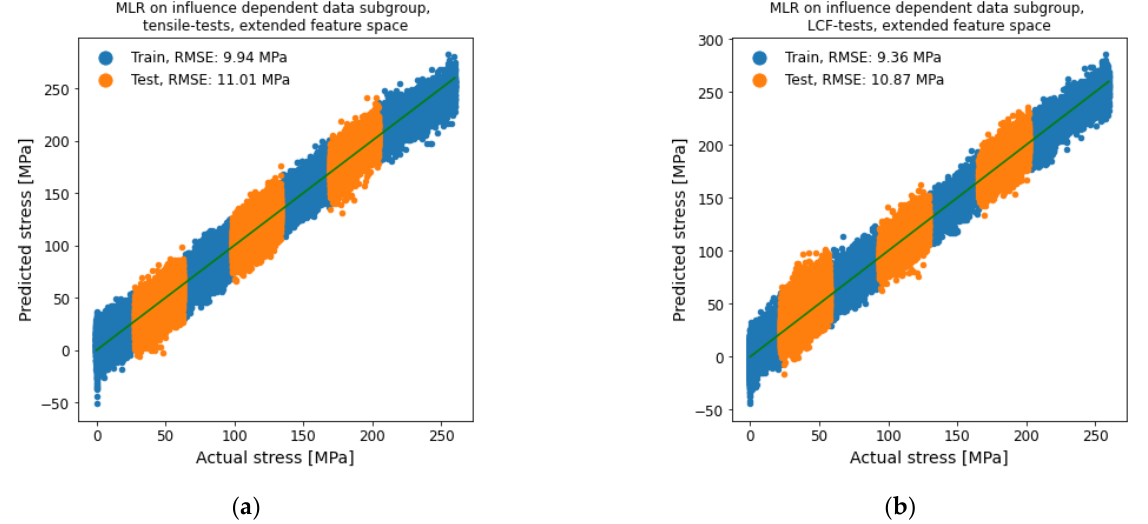
Figure 14. MLR for stress determination on influence-dependent data subgroup with extended feature space. ( a ) plastification via tensile tests and ( b ) LCF-tests.